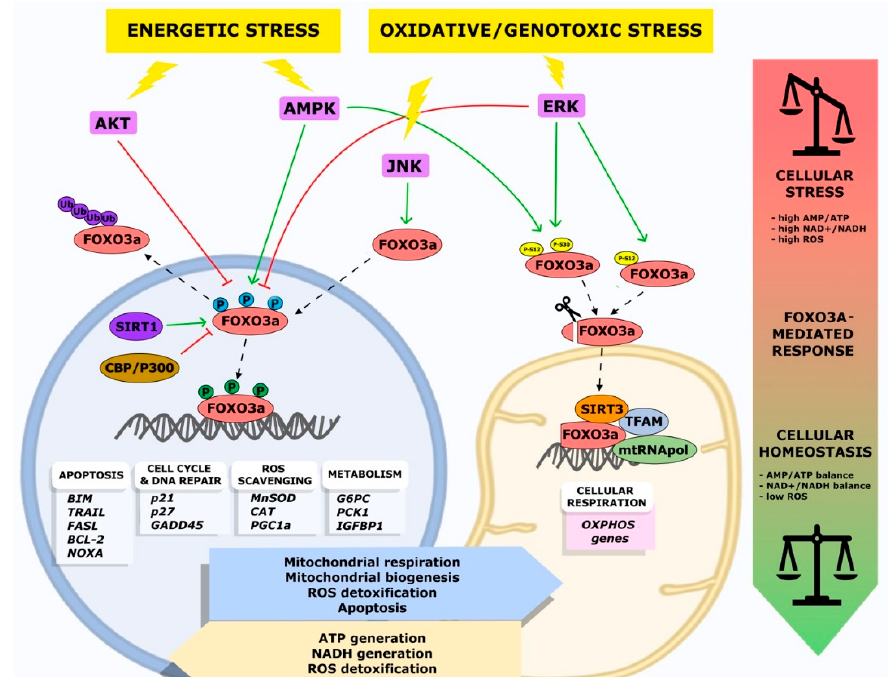
Figure 2. Schematic representation of Forkhead box O3 (FOXO3a)-mediated stress response. Perturbations of cellular homeostasis, such as nutrient shortage, high concentration of intracellular ROS, or genotoxic stress, activate FOXO3a upstream stress sensors (purple boxes), which in turn modulate FOXO3a subcellular localization and / or activity through various post-translational modifications (PTMs) (green arrows represent activation signals, red bar-headed lines represent inhibitory e ff ects). In the cytoplasm, FOXO3a is inactive and is targeted for poly-ubiquitination, which leads to its further proteasomal degradation. Upon phosphorylation by c-Jun N-terminal kinase (JNK), FOXO3a is shuttled into the nucleus, where its transcriptional activity is further regulated by an activator (e.g., 5 (cid:48) -AMP-activated protein kinase, AMPK; sirtuin 1, SIRT1) or repressor (e.g., AKT8 virus oncogene cellular homolog AKT, CREB binding protein and p300 (CBP / p300) signals. Depending on the PTM pattern, FOXO3a orchestrates di ff erent transcriptional programs involved in several cellular processes, including apoptosis, cell cycle progression, DNA repair, reactive oxygen species (ROS) detoxification, and cellular metabolism. Recent evidence showed that metabolic stress or chemotherapy treatment can also promote AMPK- and extracellular signal-regulated kinase (ERK) dependent mitochondrial accumulation of a FOXO3a cleaved form, which activates the expression of mitochondrial oxidative phosphorylation (OXPHOS) genes involved in cell survival. The crosstalk between FOXO3a nuclear and mitochondrial functions is crucial for the restoration and maintenance of cellular